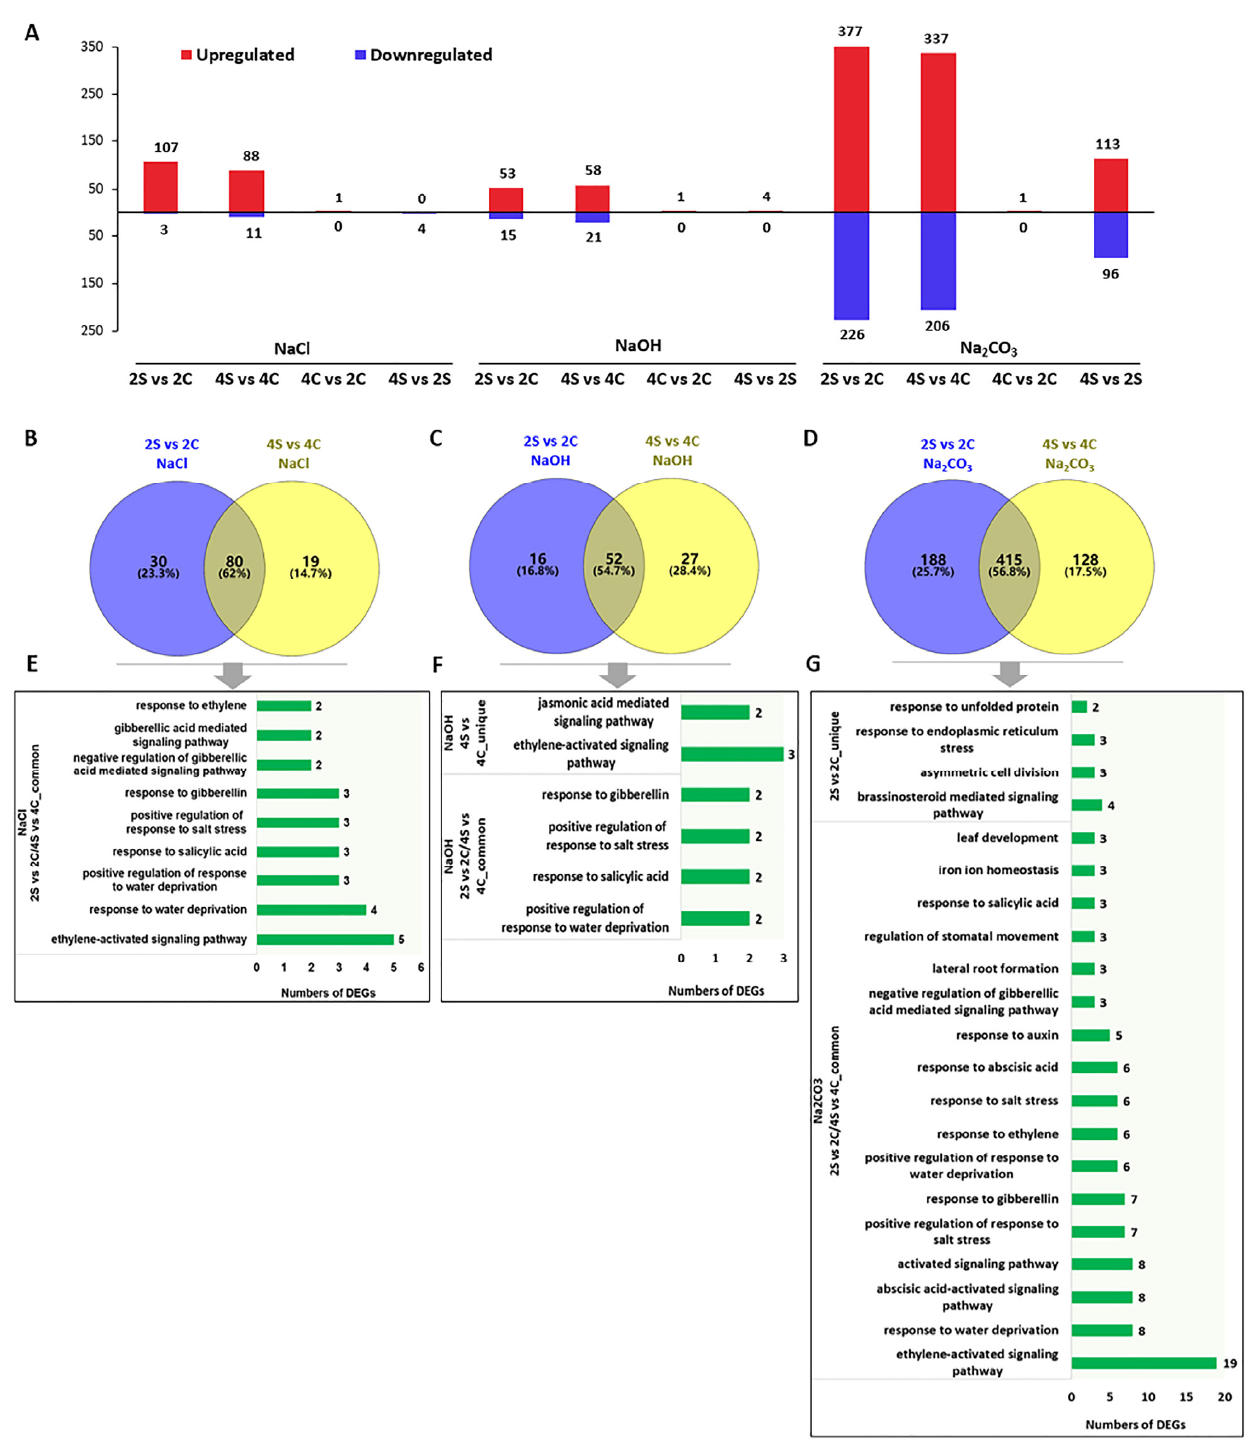
Figure 2. Analysis data of transcriptome-derived DE-TFs in diploid and tetraploid rice roots under control and NaCl, NaOH, and Na 2 CO 3 stress conditions. ( A ) Statistics of up- (in red) and downregulated (in blue) DE-TFs in roots for each pairwise comparison. Venn diagrams of DE-TFs under NaCl stress ( B ), NaOH stress ( C ), and Na 2 CO 3 stress ( D ). GO (gene ontology) analysis of DE-TFs under NaCl stress ( E ), NaOH stress ( F ), and Na 2 CO 3 stress ( G ). DE-TFs: differentially expressed transcription factors; 2C and 4C represent diploid and tetraploid plants under control conditions, respectively; 2S and 4S represent diploid and tetraploid plants under three stress conditions, respectively.